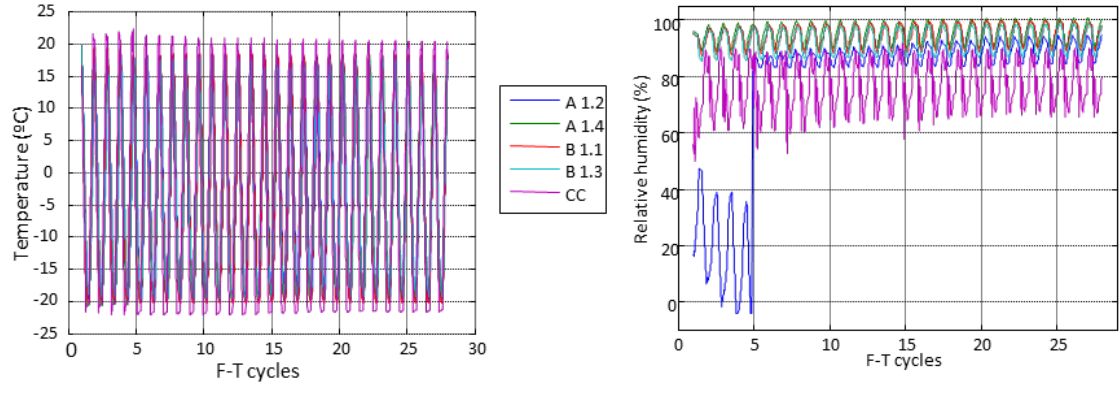
Figure 10. Temperature inside specimen A1.4.